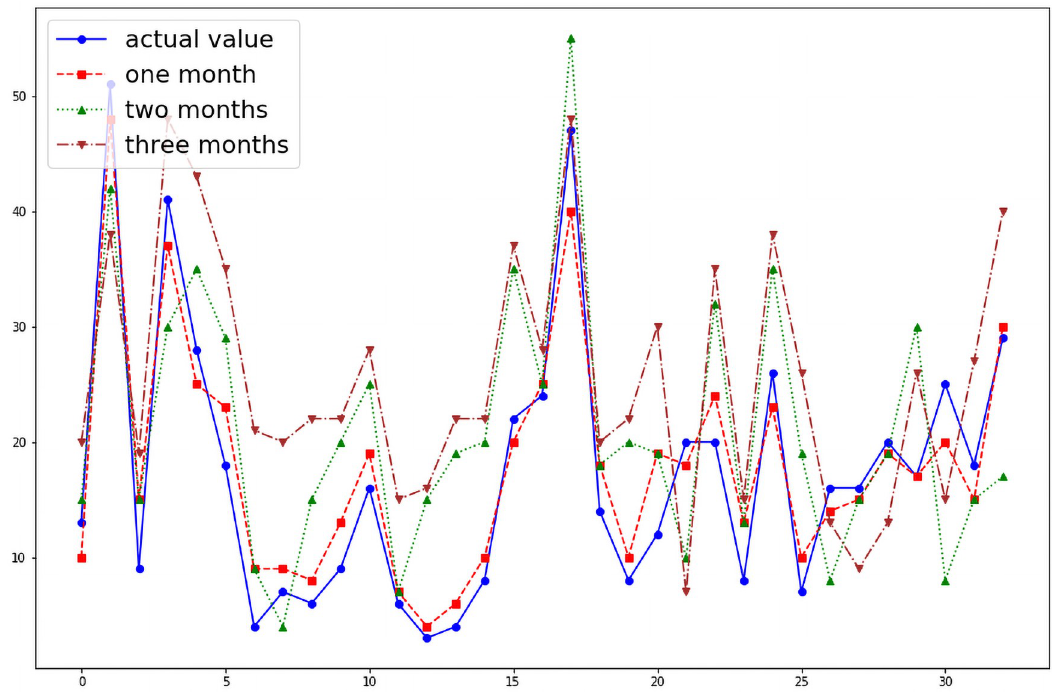
Fig 7. Comparison of model’s ability to predict the number of new cases in the succeeding months.